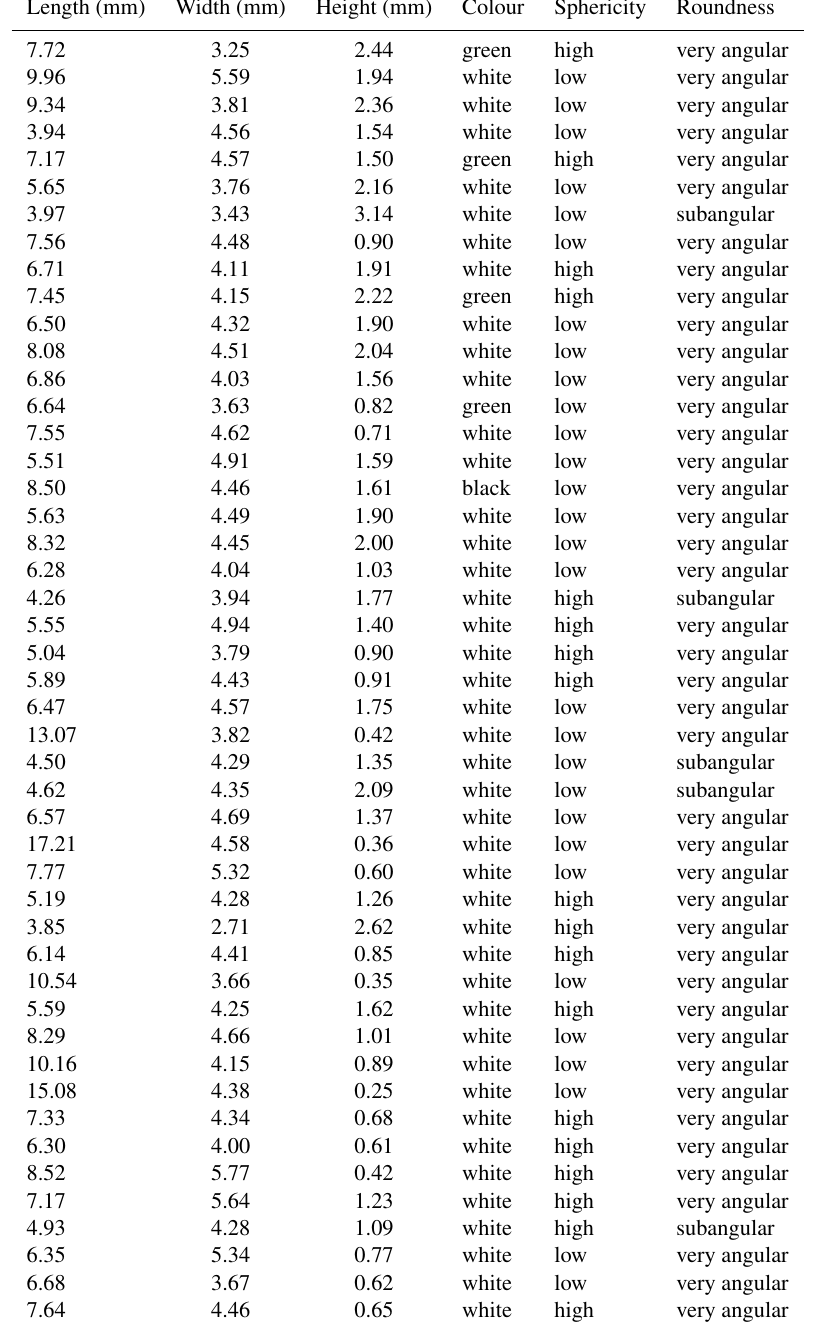
Table 1. Microplastic particle side distribution and